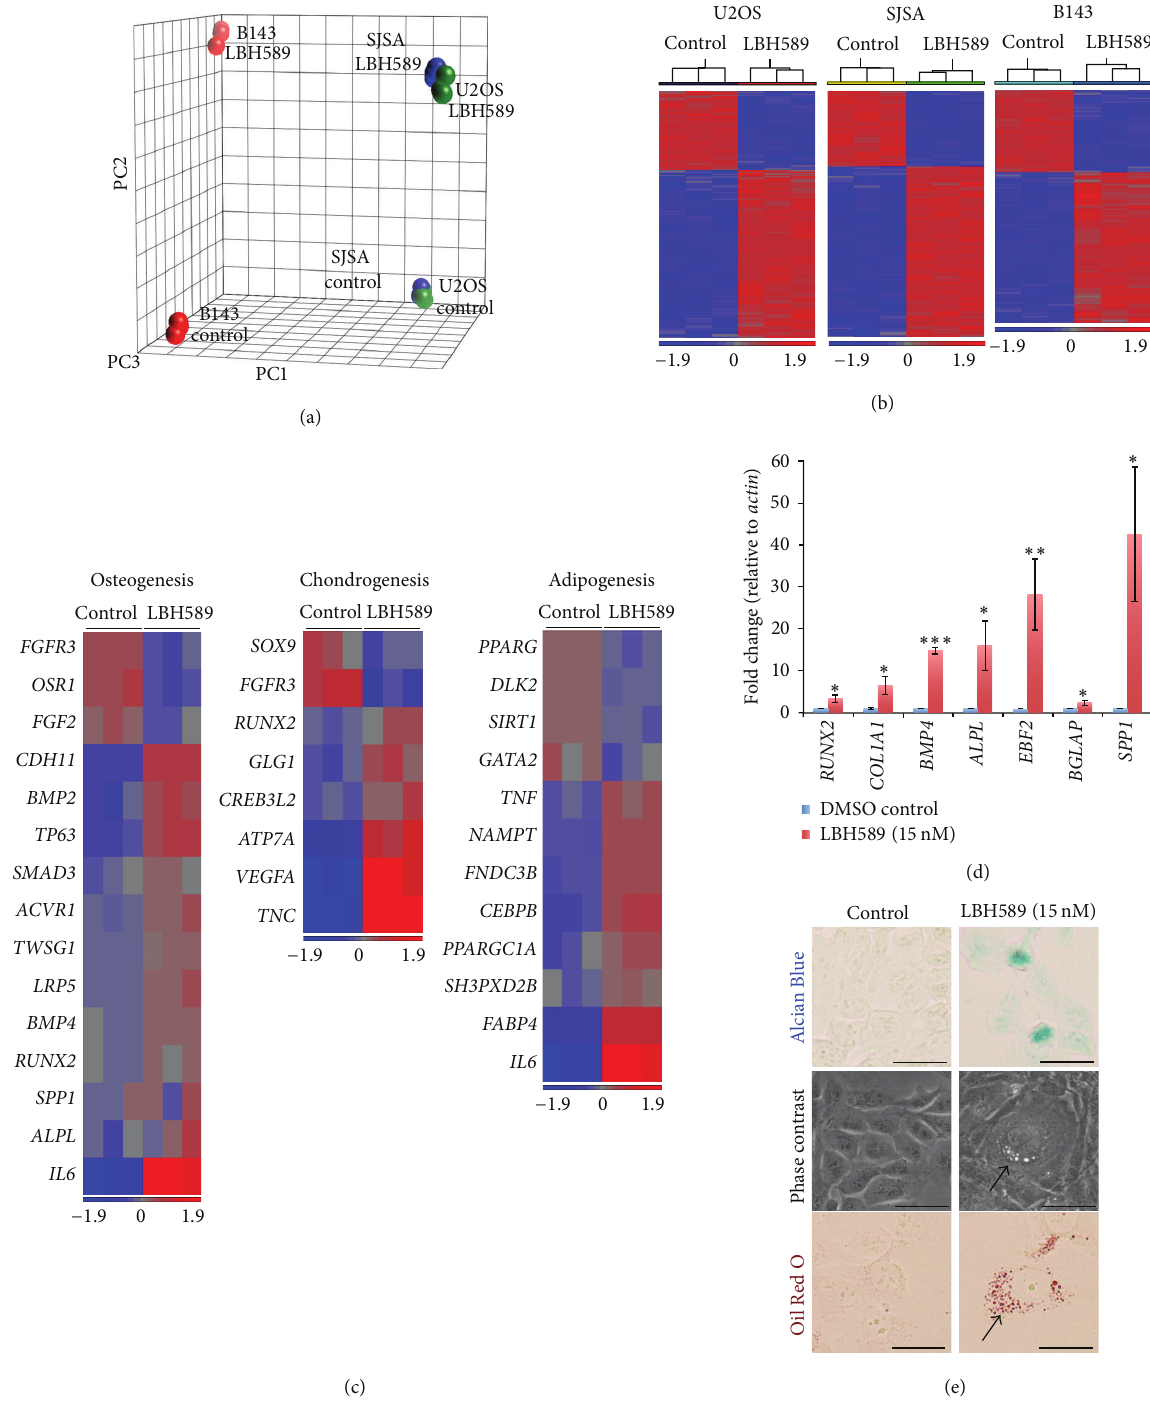
Figure 2: Microarray analysis of human osteosarcoma cell lines. (a) Principle component analysis (PCA). Three PCA coordinates describe 56% of the total data variation (PC1, 8.8%; PC2, 18.1%; PC3, 29.1%). Red, B143; blue, SJSA; green, U2OS. (b) Unsupervised hierarchical cluster analysis. Heatmap representation of differentially expressed genes in U2OS, SJSA, and B143 cells treated for 21 days with 15nM LBH589 or DMSO. Each column represents a distinct sample, and each row represents an individual gene. Level of expression is denoted by colour (blue, low; red, high). (c) Heatmap representation of genes enriched in functional groups associated with osteogenesis, chondrogenesis, and adipogenesis. Each column represents a distinct sample. (d) Quantitative real-time PCR of U2OS cells cultured for 21 days in the presence of 15nM LBH589 for expression of osteoblast differentiation markers. ∗ 𝑃 < 0.05 , ∗∗ 𝑃 < 0.01 , and ∗∗∗ 𝑃 < 0.001 . (e) Analysis of chondrocyte and adipocyte differentiations of human osteosarcoma cells treated for 21 days in 15nM LBH589 by Alcian Blue staining, a marker of cartilage extracellular matrix, phase contrast microscopy, and the triglyceride marker, Oil Red O. Scale bar = 250 𝜇